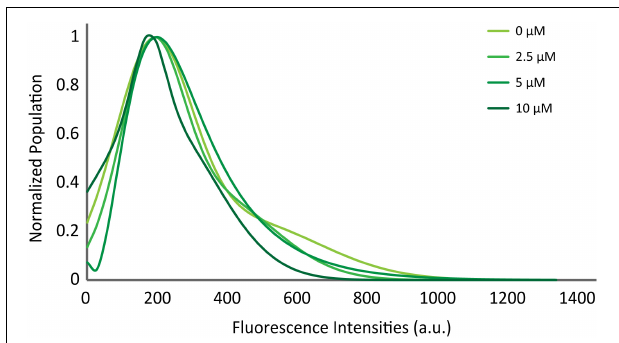
FIGURE 4 | α S does not promote clustering of vesicles on the supported bilayer. Distribution of initial fluorescence intensities of individual docking events at various concentrations of twice purified α S. The maximum population for each concentration is normalized to 1 for comparison. The initial intensities of 2,194 docking events from 58 independent recordings are